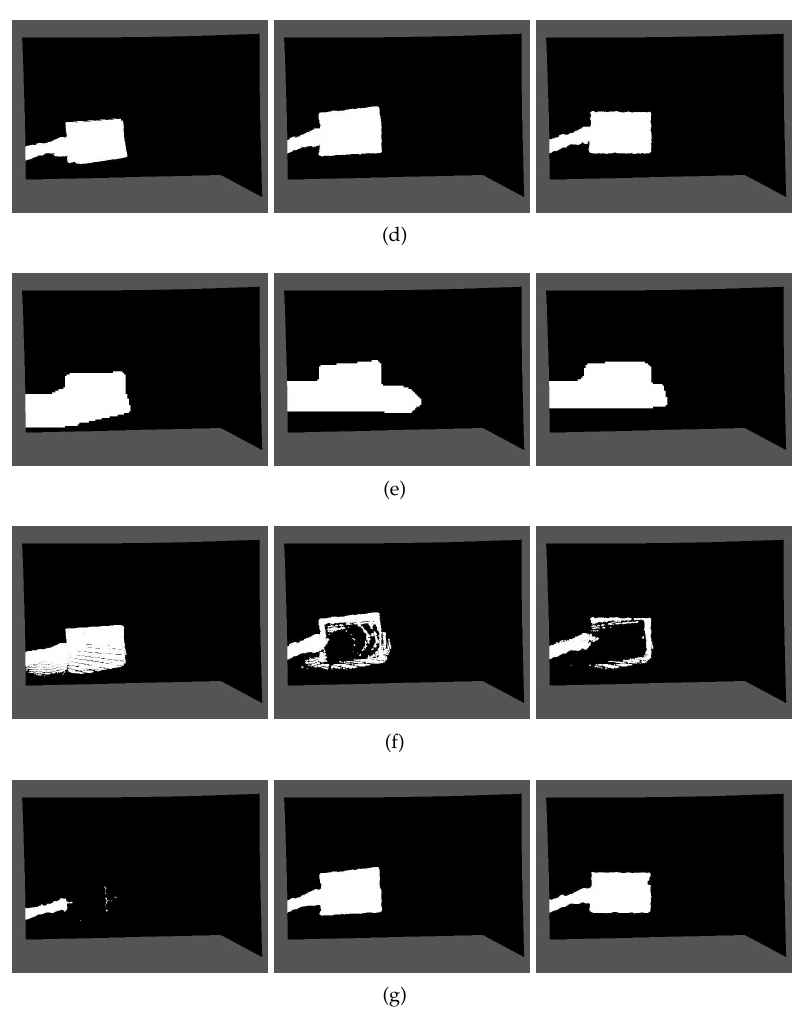
Figure 9. Comparison of the detection results of the two algorithms in Experimental Scenario One: ( a ) Ground truth; ( b ) The detection result of the original codebook algorithm; ( c ) The detection result of the original codebook algorithm with noise points removed using morphological operations; ( d ) The detection result of the algorithm proposed in this article; ( e ) The detection result of the SRPCA method; ( f ) The detection result of the CwisarDH + method; ( g ) The detection result of the BSABU